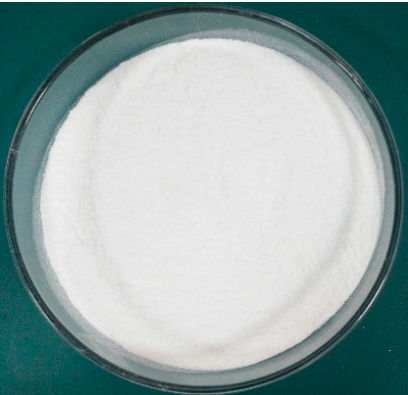
Figure 1. Phase-change thermal-insulation agent (PCTIA).